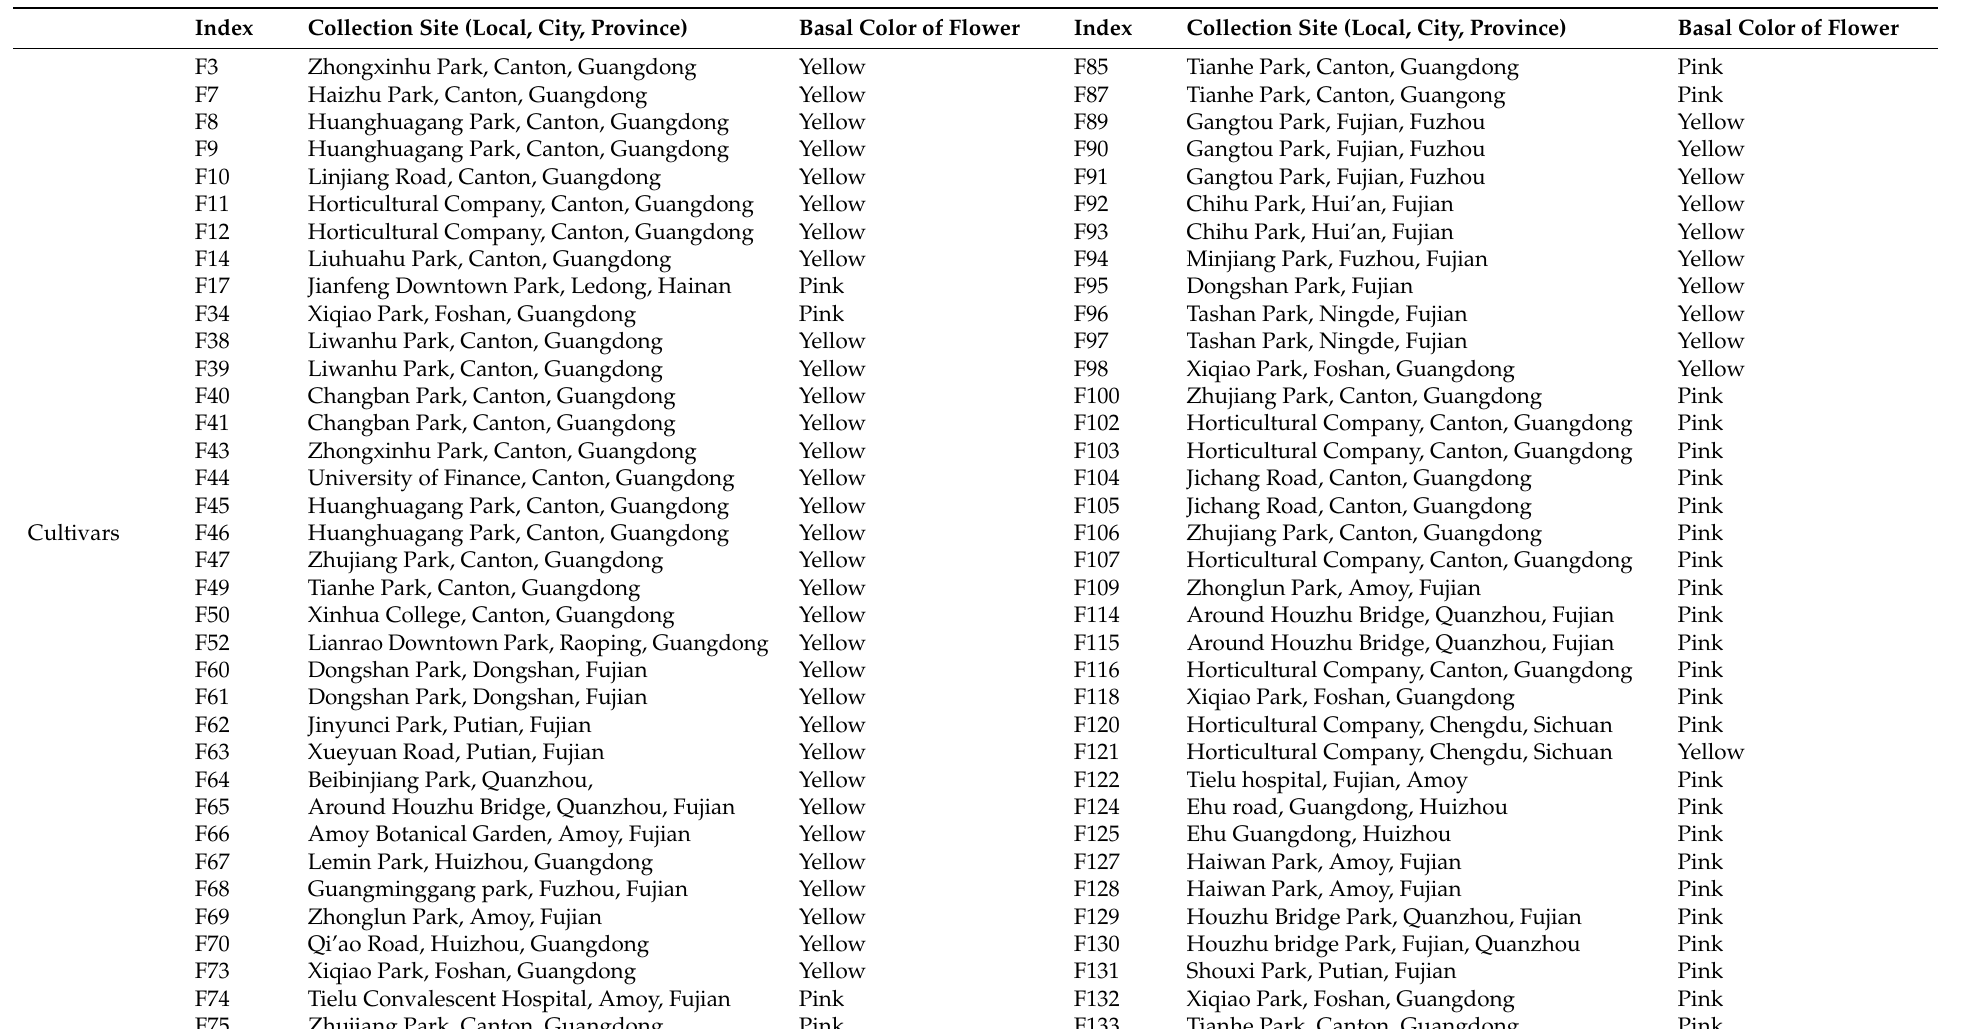
Table 1. The test samples of 82 cultivars and 12